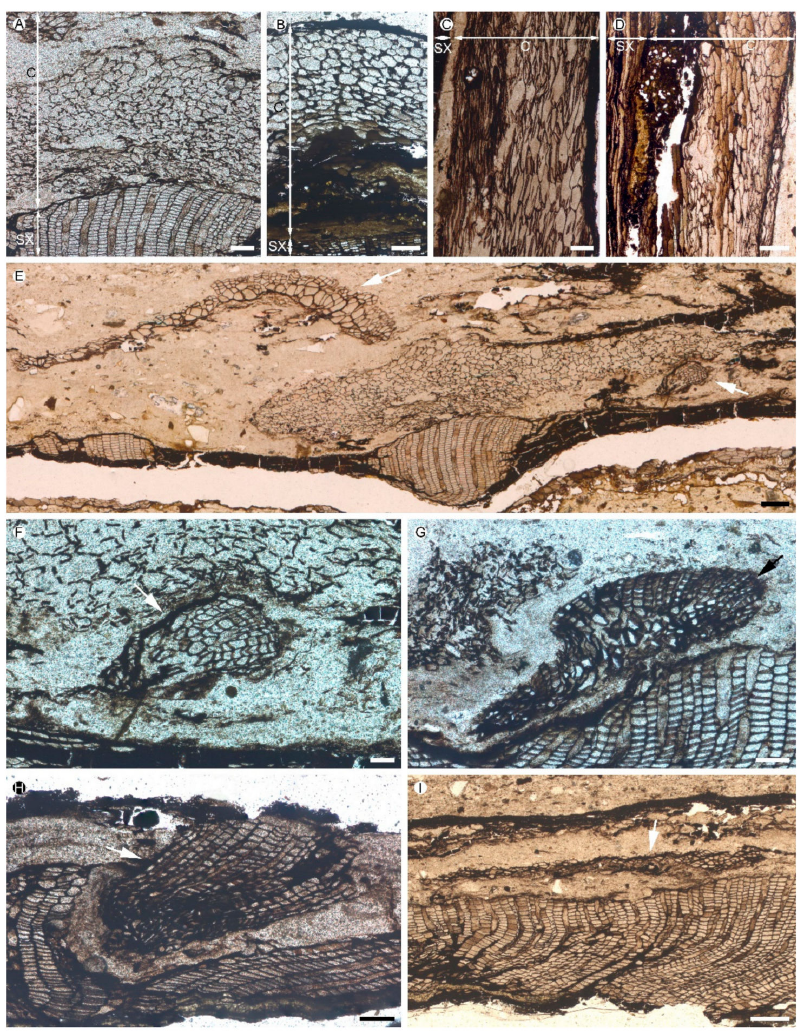
Figure 9. The cortex and leaf traces structures of Tingia unita from the Taiyuan Formation of Wuda Coalfield, Inner Mongolia. ( A , B ) Cross section of the stem, showing the secondary xylem (SX) and cortex (C). Scale bars: ( A ) = 100 µ m; ( B ) = 200 µ m. Collection numbers: ( A ) PB201150; ( B ) PB201152. nally elongated parenchyma cells in the cortex. Scale bars: ( C ) = 200 µ m; ( D ) = 200 µ m. Collection section of the stem, showing the leaf traces (arrows) in different shape. Scale bars: ( E ) = 200 µ